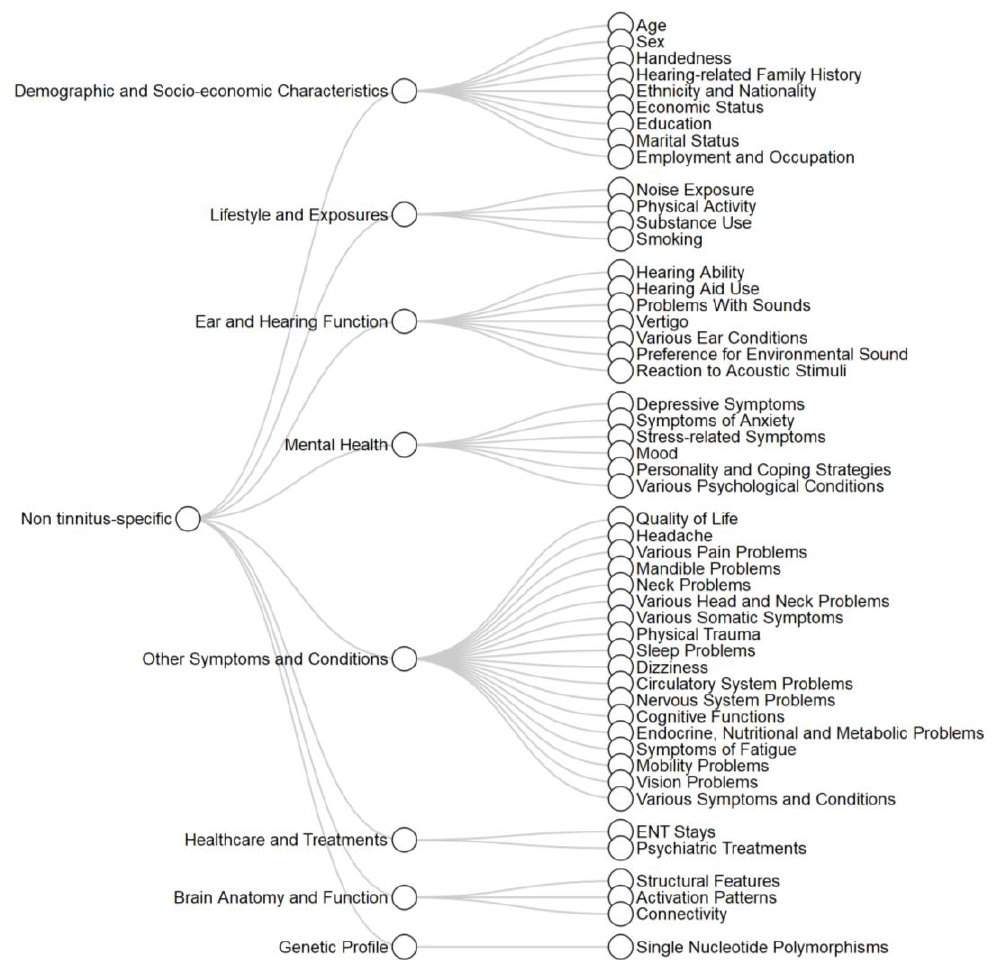
Figure 3. Non tinnitus-specific variables.